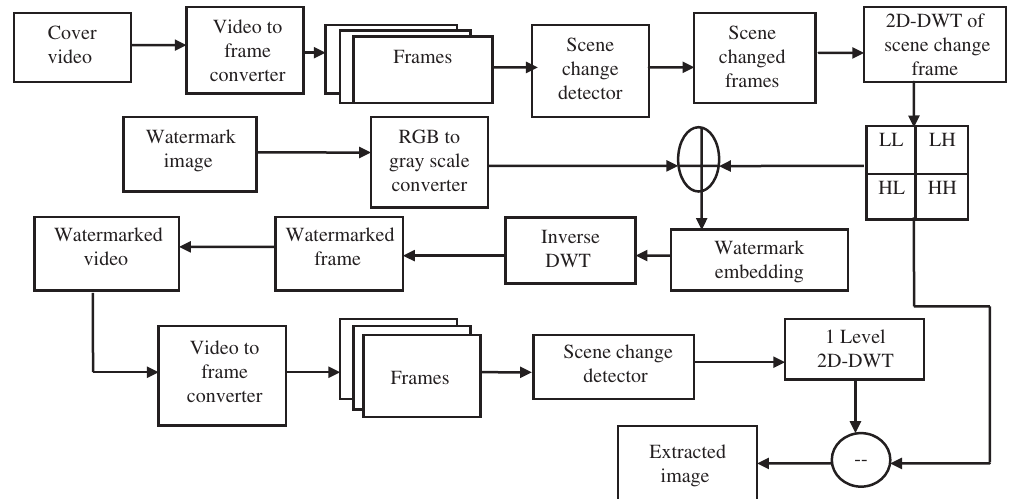
Figure 1: Scene-Based Video Watermarking System Using